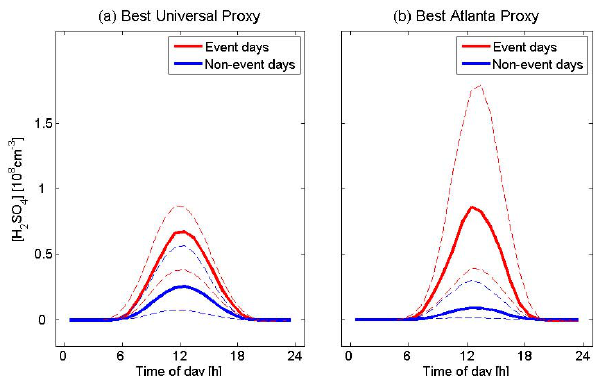
Fig. 8. Diurnal cycles of median values of two sulfuric acid proxies, according to Mikkonen et al. (2011). Separated for days with and without new particle formation. The dashed lines represent the re- spective quartiles. (a) Best universal proxy. (b) Best Atlanta